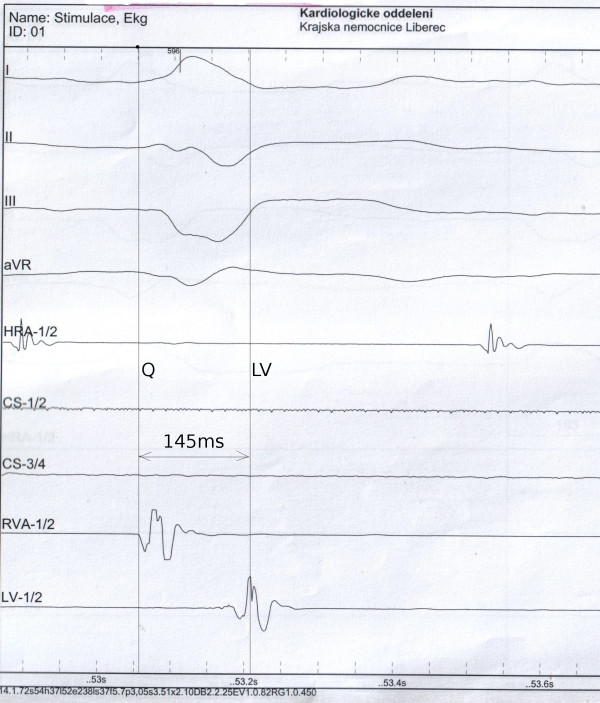
Measurement of the QLV. Printout of the electrophysiological recording system at 200 mm/s paper speed showing the interval from the beginning of the native QRS complex to the local electrogram from the LV lead. Labels: Lead II, III, aVR of the surface ECG; RVA-1/2 - right ventricular electrogram; LV-1/2 - LV electrogram; HRA 1/2 - right atrial electrogram.